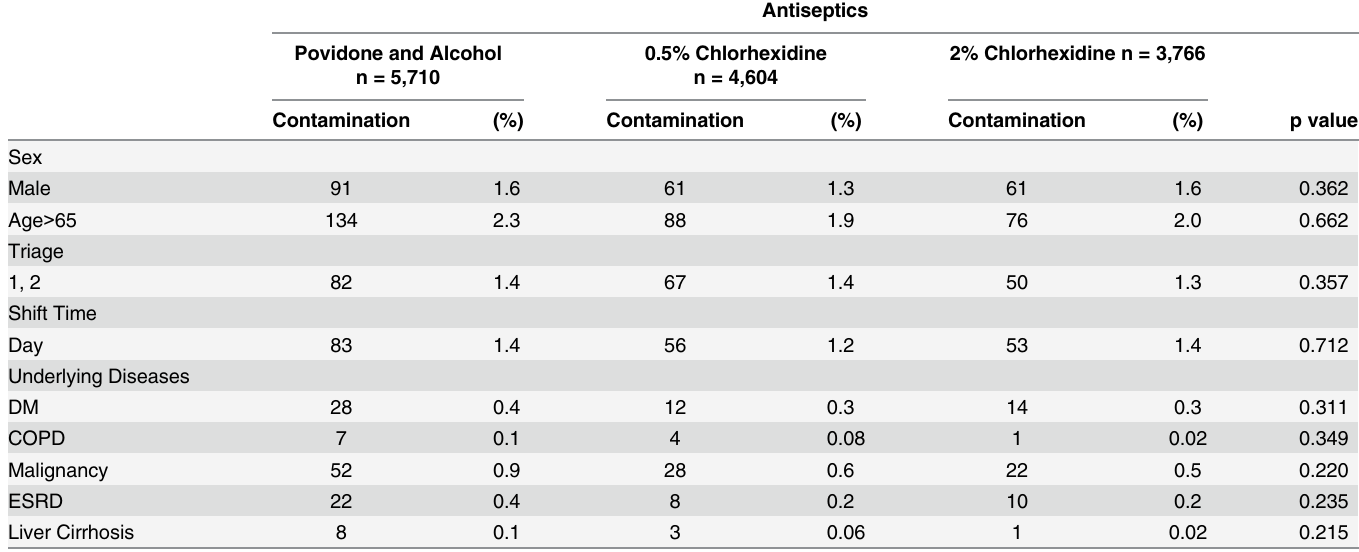
Table 2. Stratified analysis for risk factors that might contribute to blood culture contamination among ED patients.